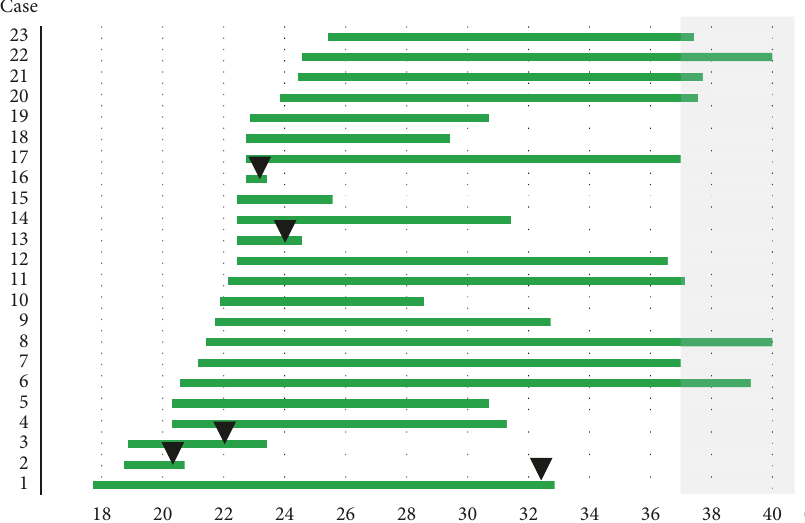
Figure 1: Duration between cerclage and delivery. GA, gestational age (weeks). 󳶃 indicates GA at preterm rupture of membranes.